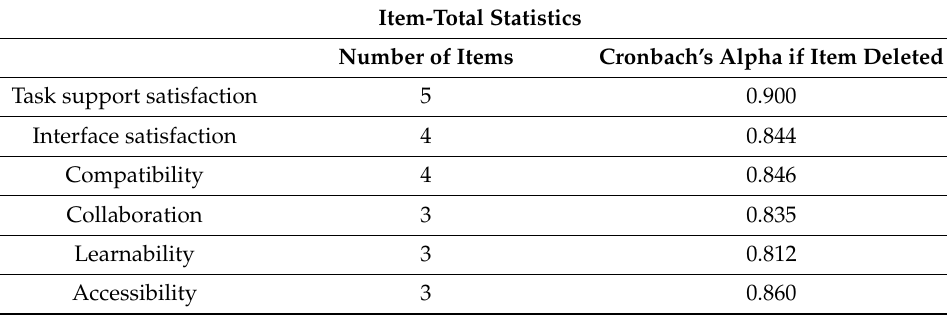
Table 7. Cronbach’s alpha coefficients for HIS component